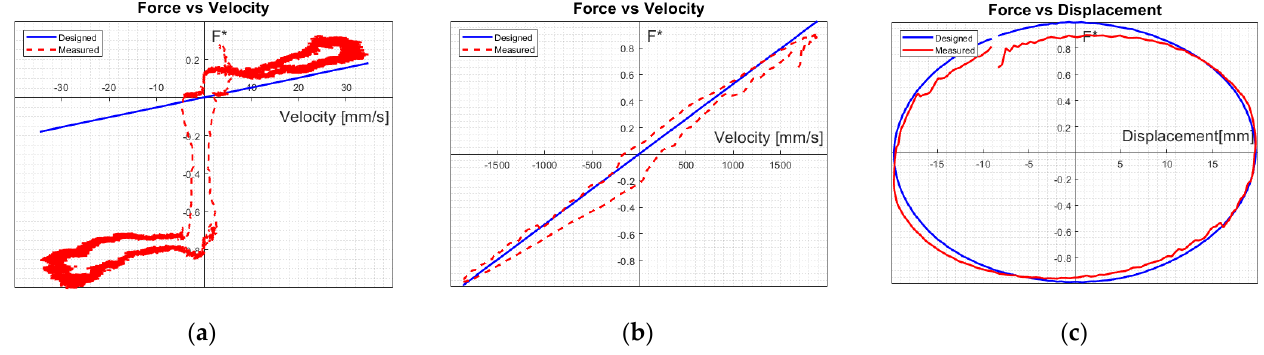
Figure 11. Characteristics of the ( a ) force–velocity at 0.1 Hz ( b ) force-velocity at 15 Hz; ( c ) force- displacement at 15 Hz: comparison between the measurements (laboratory test rig) and predictions (FE EC damper model).